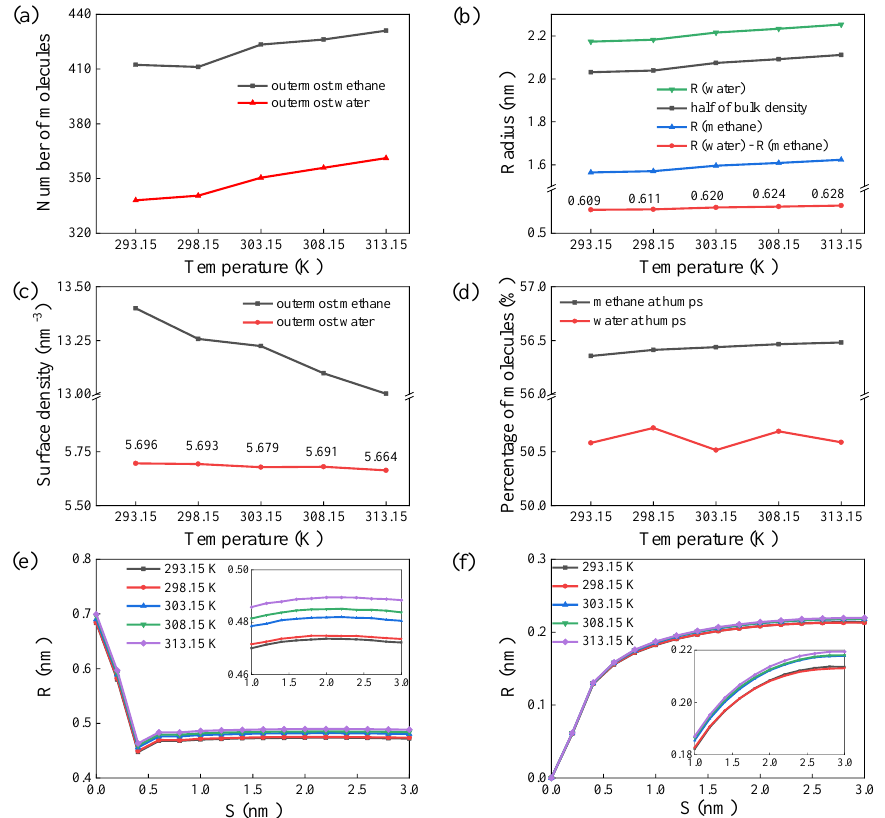
Figure 6. Time averages of ( a ) the total numbers of outermost methane and water molecules, ( b ) bubble radii, ( c ) the surface densities of the outermost methane and water molecules, ( d ) percentages of methane and water molecules at humps, and R as a function of S for ( e ) the outermost methane molecules and ( f ) the outermost water molecules in Sys6_8MPa at different temperatures. With the increase in pressure, the radii of the gas bubbles decreased, and the mean dif- ferences in radii of the outermost methane and water molecules also decreased (Figure